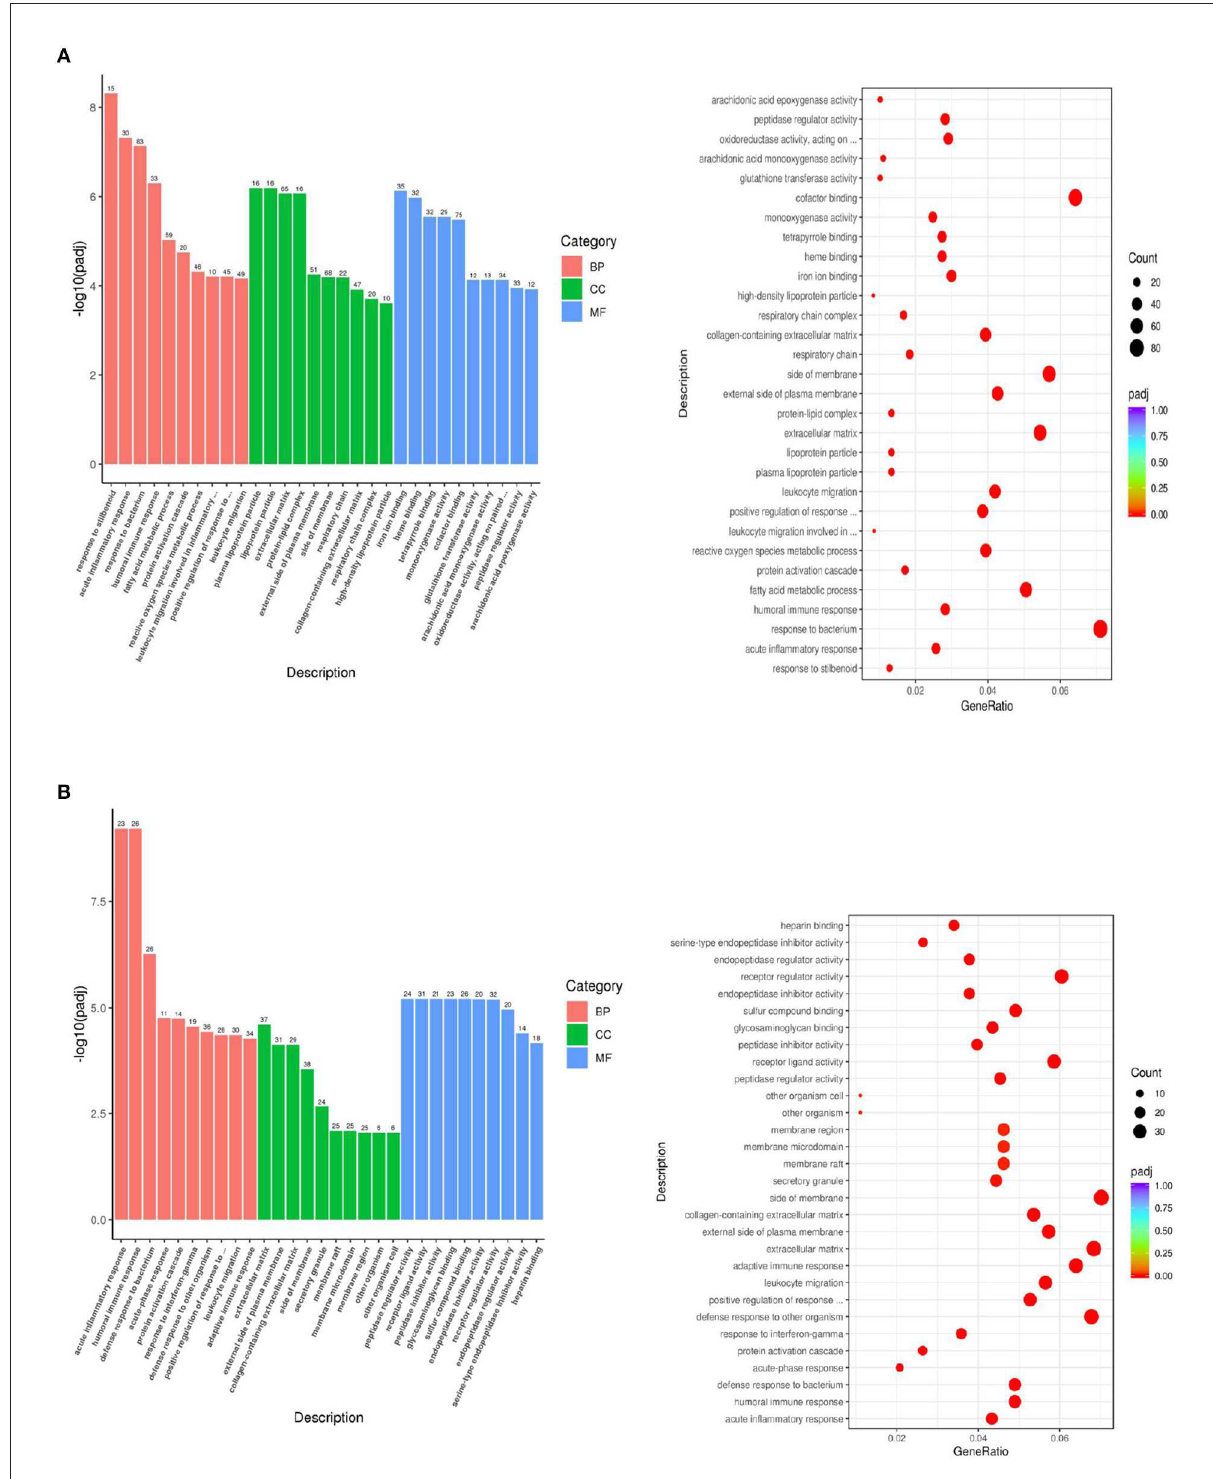
FIGURE5 GO function analysis of difference gene expression. (A) Control vs. DTE; (B) Control vs.